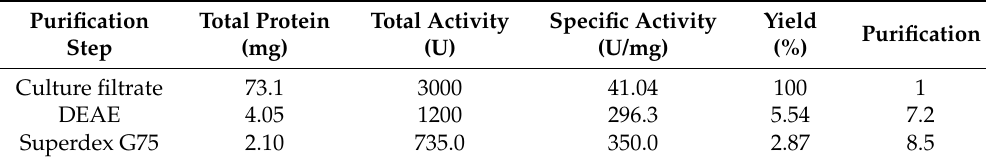
Figure 4. SDS-PAGE analysis of the purified trypsin. Lane 1: Crude enzyme; Lane 2: DEAE collected fluid; Lane 3: G75 collected fluid; M: Standard protein marker. Table 3. Results of trypsin purification